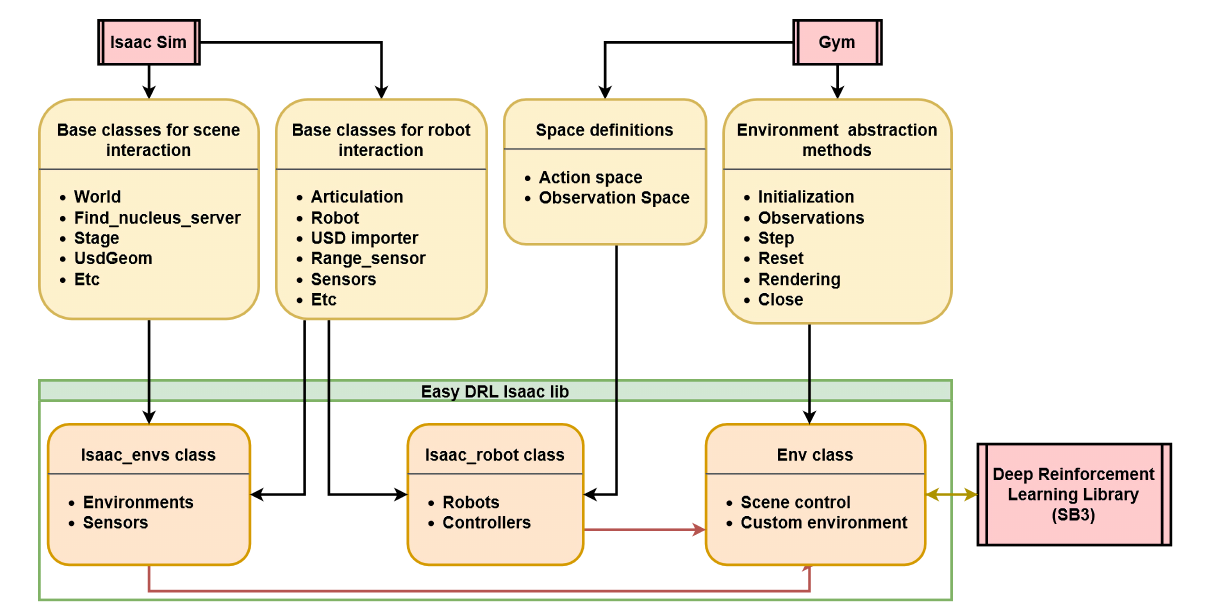
Figure 4. The main elements of the proposed library and how they interact with Isaac Sim, Gym, and